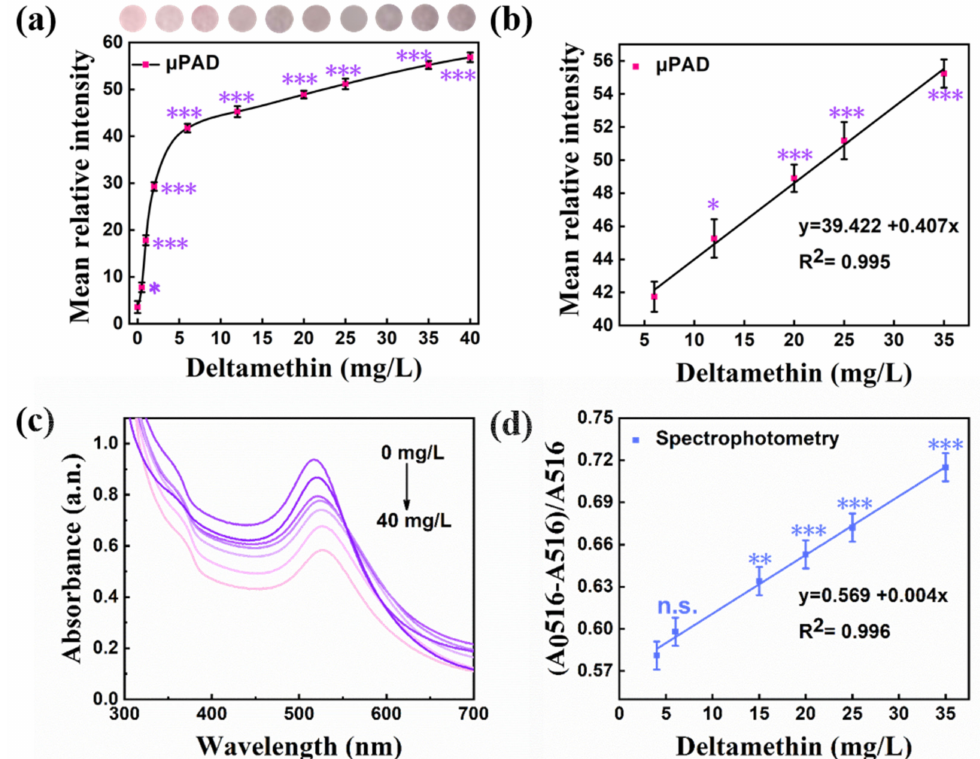
Figure 4. ( a ) The dependence of mean relative intensity on the concentration of DEL (* p < 0.5 and *** p < 0.001, compared to Deltamethin 0.1 mg/L condition). ( b ) The linear relationship between DEL concentration and gray intensity of µ PAD (* p < 0.5 and *** p < 0.001 compared to Deltamethin 6 mg/L condition). ( c ) The dependence of absorption spectrum on the concentration of DEL. ( d ) The linear relationship between DEL concentration with absorption ratio of spectrophotometry (n.s., not significant, ** p < 0.01 and *** p < 0.001 compared to Deltamethin 4 mg/L